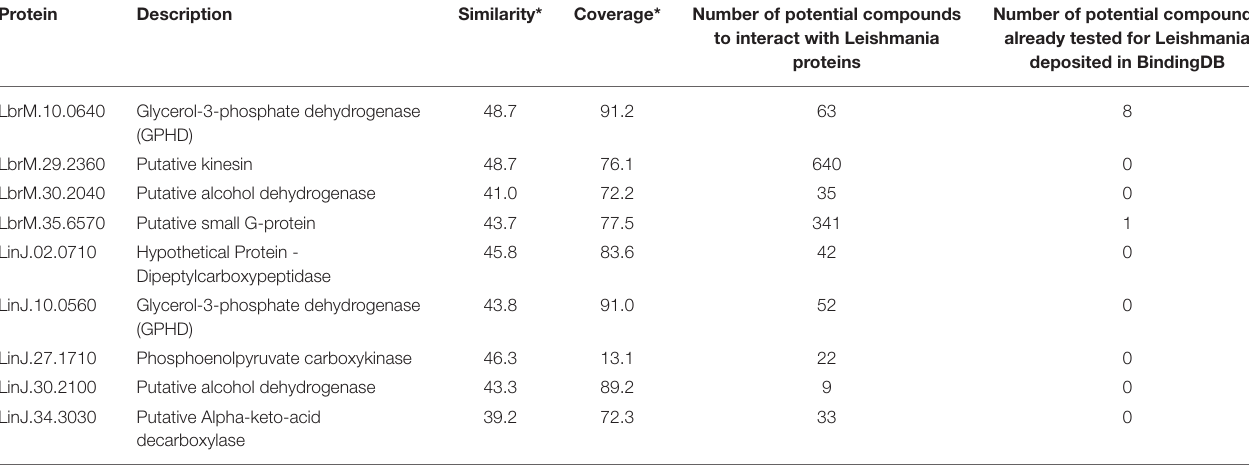
TABLE 2 | Potential drug targets with relative PIN essentiality and < 50% similarity to the human proteome. Protein Description Similarity* Coverage* Number of potential compounds